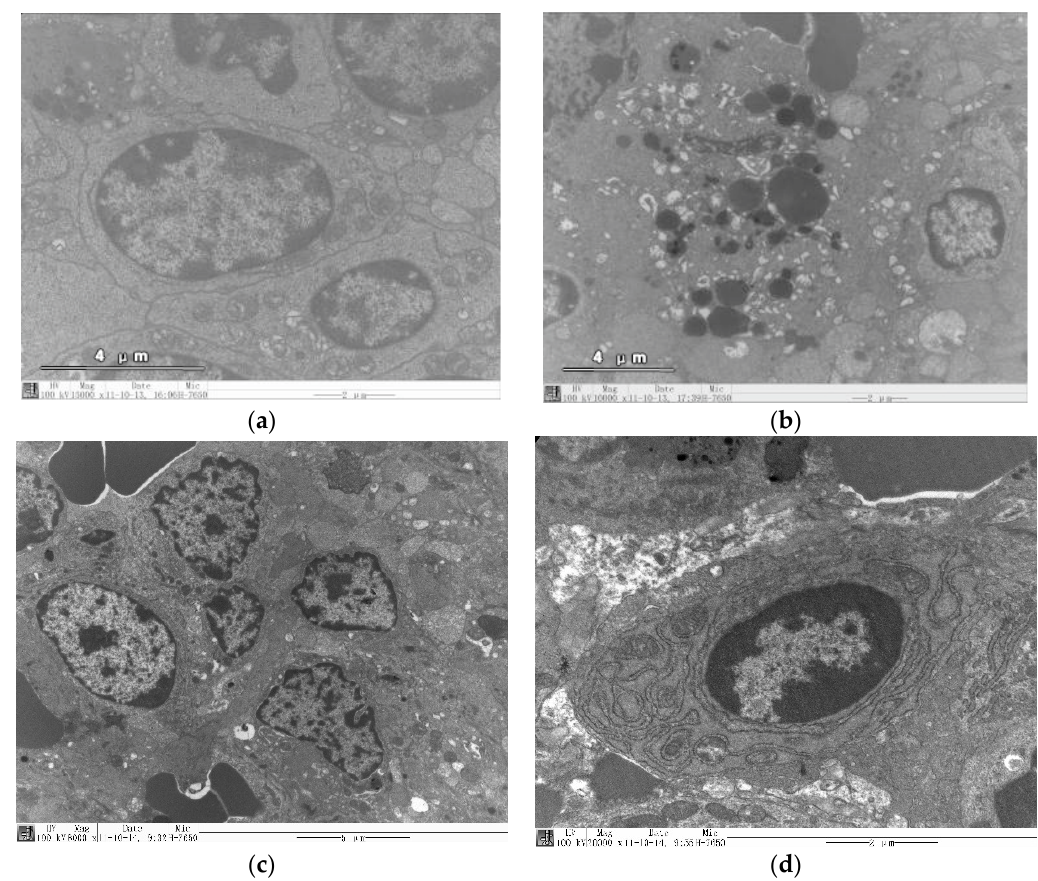
Figure 3. Microstructure analysis of mice spleen treated with YG (Yeast glucans) and SYG using Transmission Electron Microscopy. ( a ) Control; ( b ) Irradiated mice ( c ) Irradiated mice treated with YG; ( d ) Irradiated mice treated with SYG